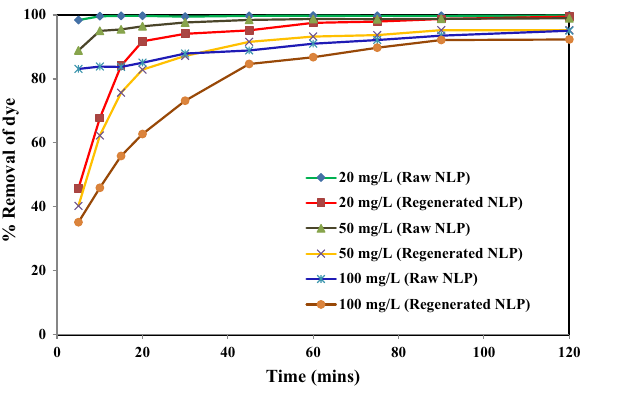
Fig. 10 Removal capacity of regenerated NLP for various solute con- centration of MG (NLP: 3 g/l, pH: 4.97, Temp: 308 K)